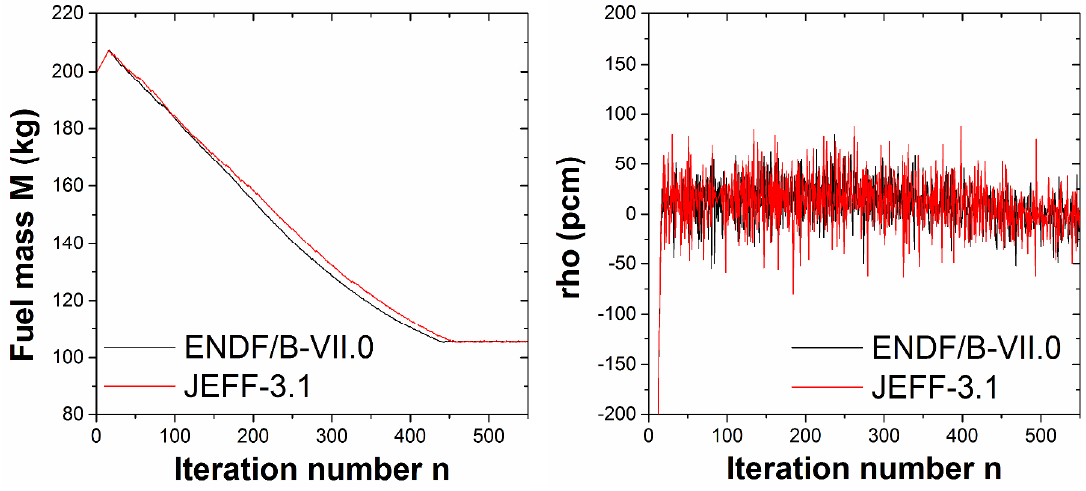
Figure 4. Evolutions of the fuel mass M and the reactivity rho in pcm with the iteration number n . In Fig. 3 is observed the occurrence of small heterogeneities in the LEU fraction profiles, which are not mere statistical fluctuations. Indeed, the LEU fractions were purposely changed by very small increments,  = ± 5.10 -3 %, between two iterations of the algorithm (hence the artificially large number of iterations to converge). This increment is small compared to the amplitude of the observed heterogeneities, ∼ 0.2%. Hence, one might wonder if these heterogeneities play a role in reducing the critical mass. To investigate this question, the ENDF/B-VII.0 LEU fraction curve was smoothed using a Savitzky-Golay approach [15] while preserving the mass M . The reactivity obtained with the smoothed profile remained compatible with 0. The observed heterogeneities are therefore probably artifacts. The author sees three possible reasons for their occurrence: (1) a segregation induced by decorrelations of fission sites that may occur in a meter- size object; (2) a consequence of the non-zero statistical errors on the k